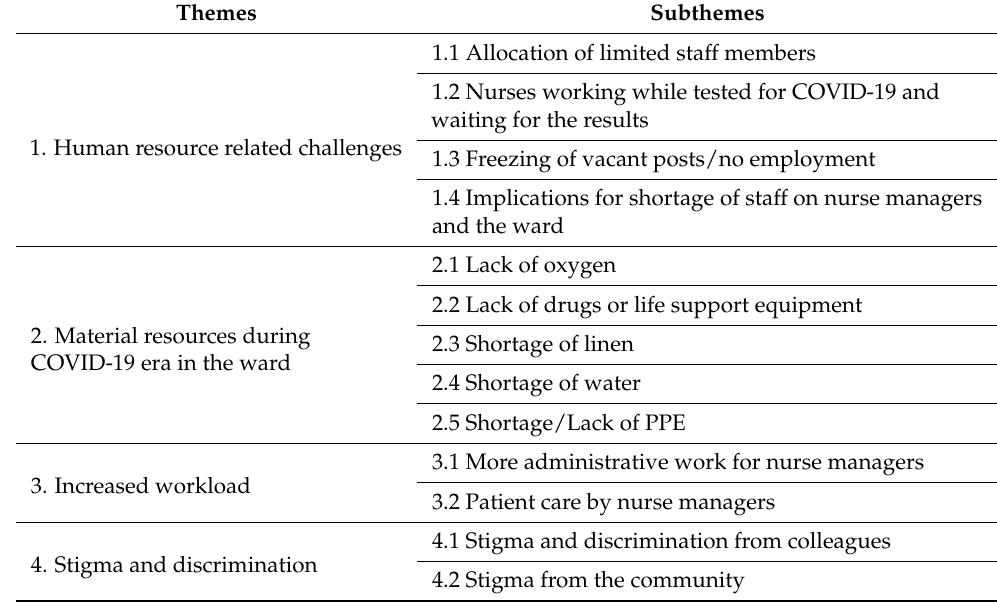
Table 2. Summary of themes that emerged from data